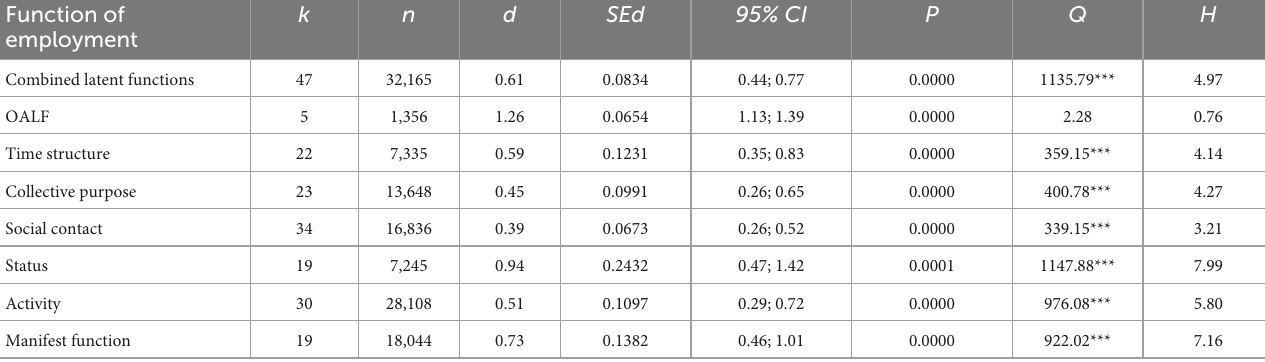
TABLE 1 Latent and manifest functions of employment–differences between employed and unemployed